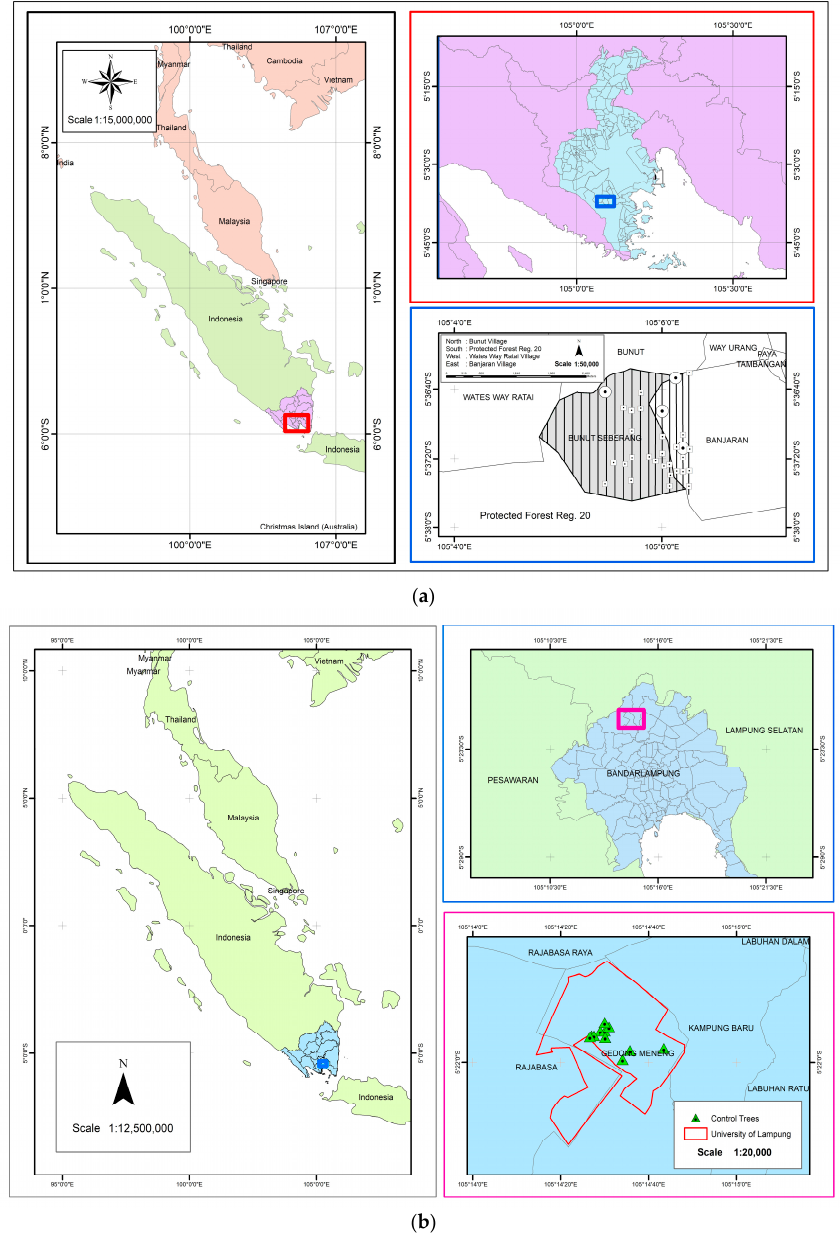
Figure 1. The research location ( a ) Bunut Seberang Village and ( b ) University of